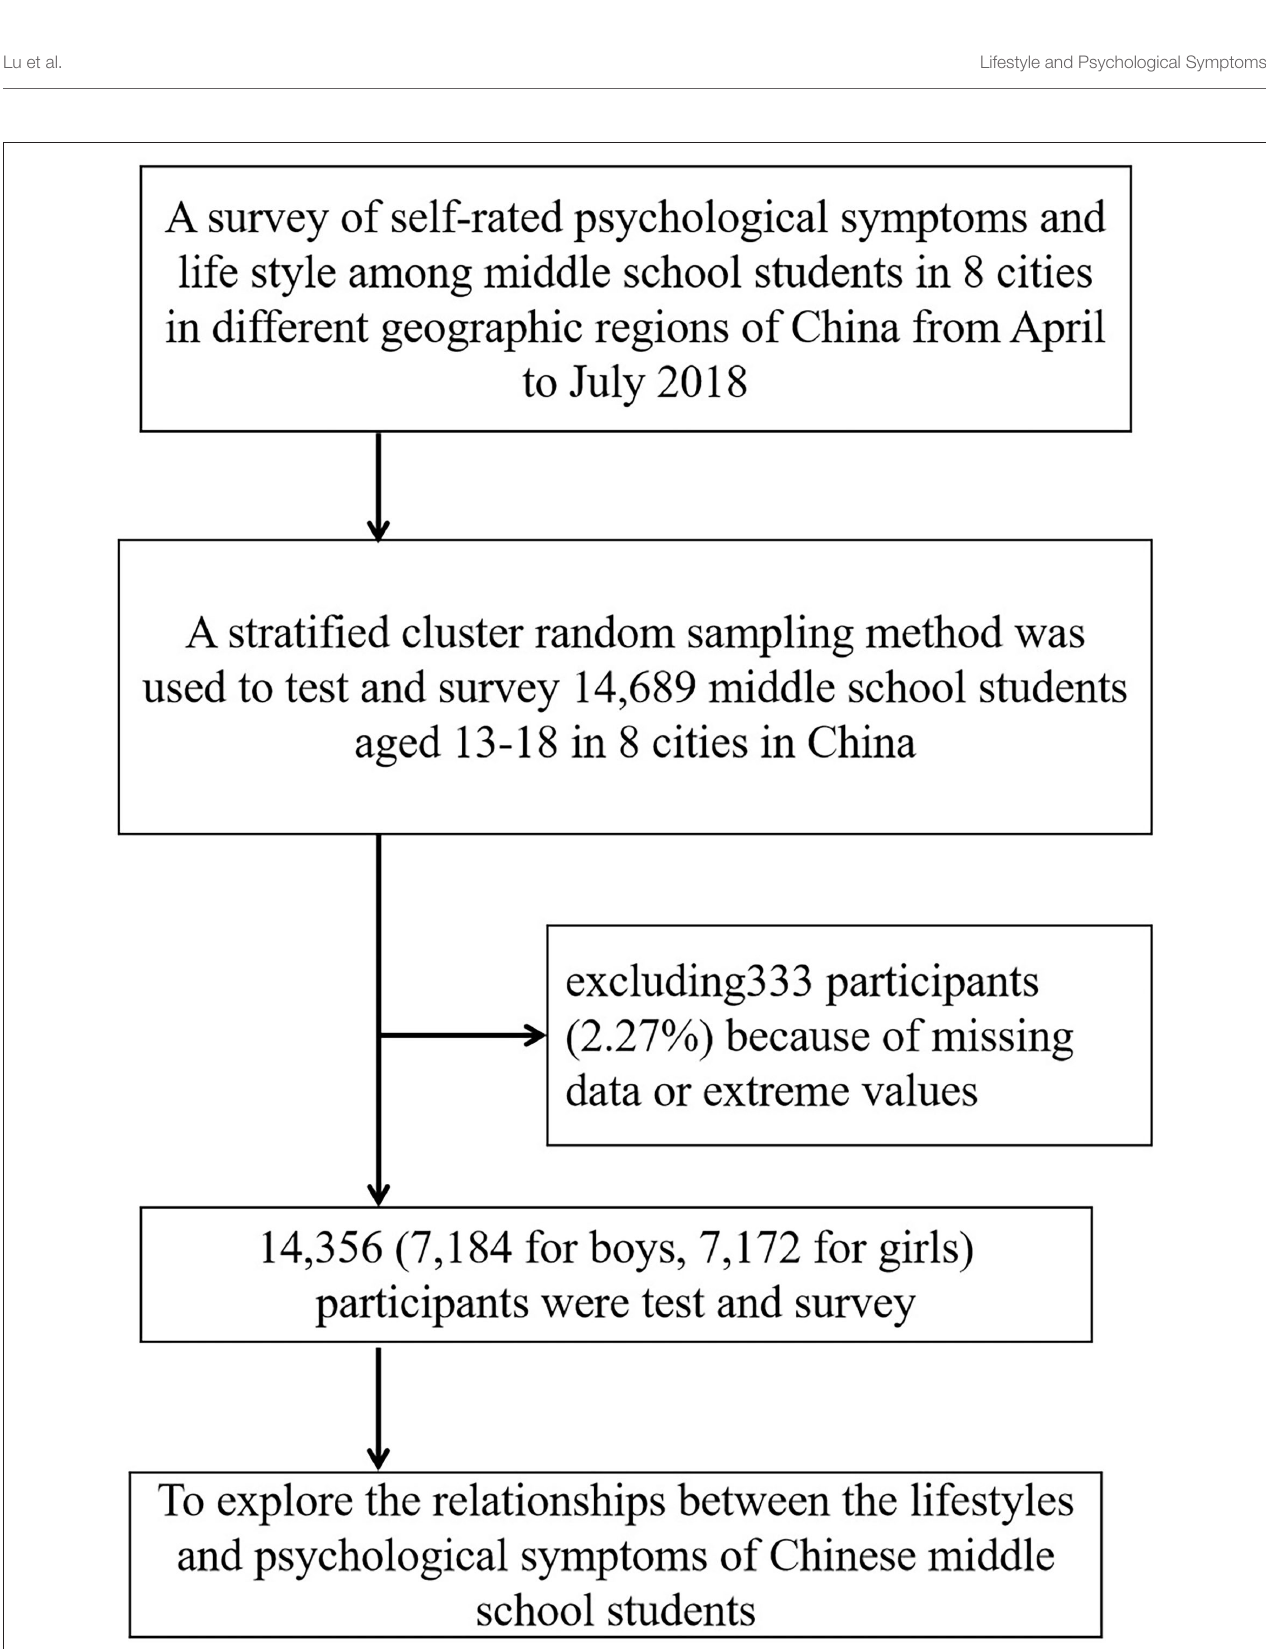
FIGURE 1 | Sampling flow chart of Chinese middle school